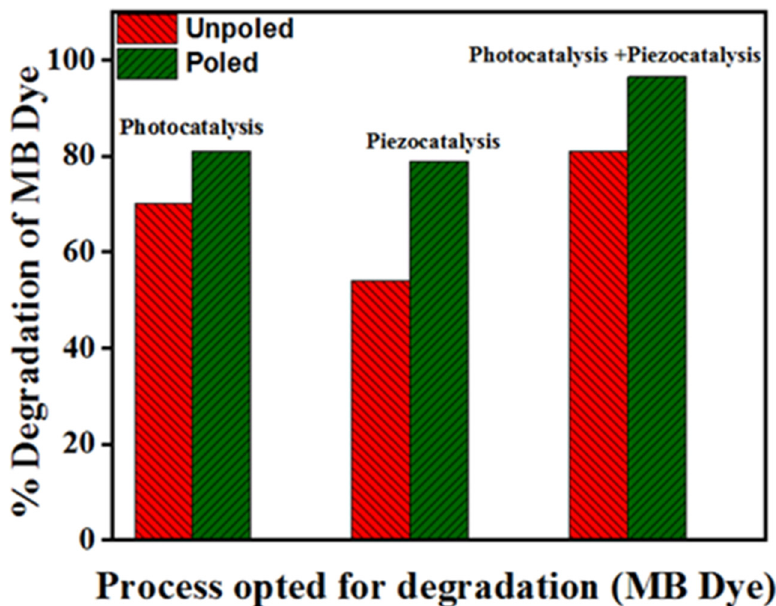
Figure 9. % Degradation achieved by using unpoled and poled BST-BZT sample in photocatalysis, piezocatalysis, and piezo-photocatalysis process.